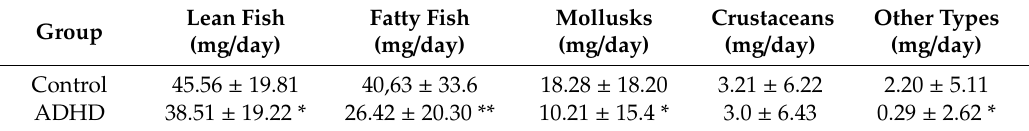
Figure 2. Estimated daily EPA + DHA intake from seafood. Comparison of EPA + DHA intake in the control and ADHD groups. Significant di ff erence reported with an asterisk *, p < 0.05. Table 2. Estimation of Omega-3 LC-PUFA intake form di ff erent type of fish and seafood.